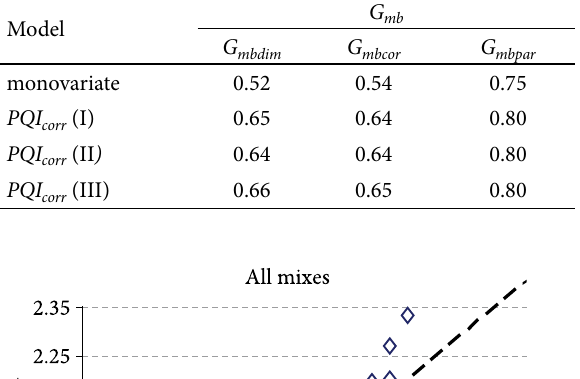
Table 6. Regressions G mb vs. P CE : R 2 values Model